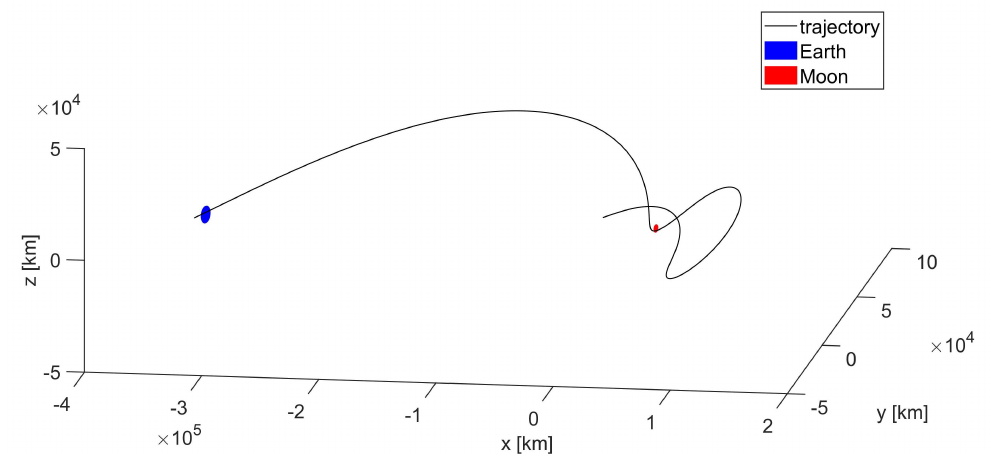
Figure 1. Spacecraft trajectory during Phase 1.